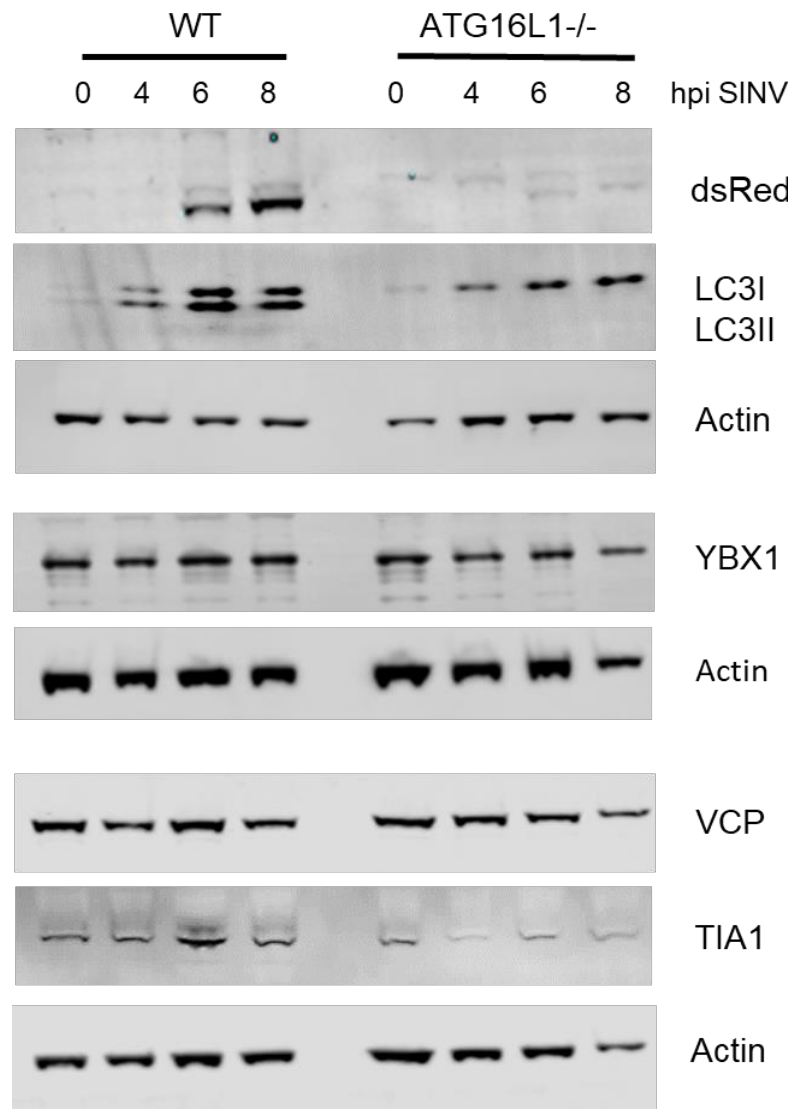
Figure 4. Host translational RNA-binding proteins are not degraded by autophagy induced by SINV infection. A time course of SINV infection from 0–8 hpi in wild type (WT) and ATG16L1-/- MEFs (ATG16L1-/-). Western blot of protein lysates with antibodies against LC3, YBX1, TIA1 and VCP, with actin showing equal lane loading for each gel.